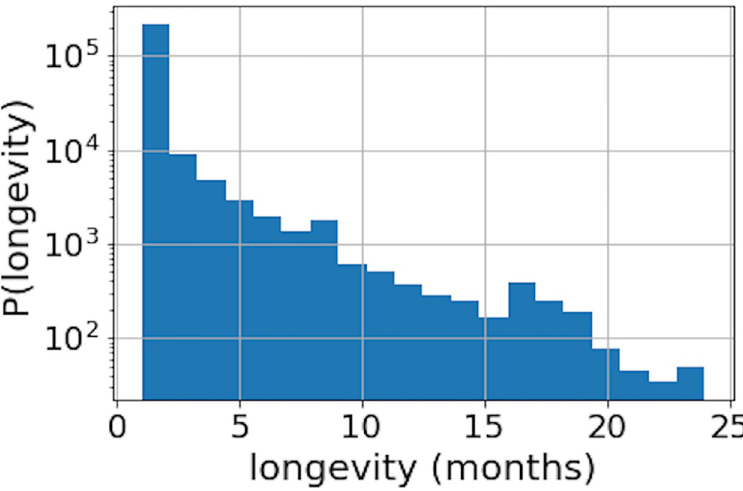
Fig 6. Longevity distribution for nodes in the second (stable) period. Most of the nodes stay in the network for a short period, while only a few nodes remained active for more than 20 months.